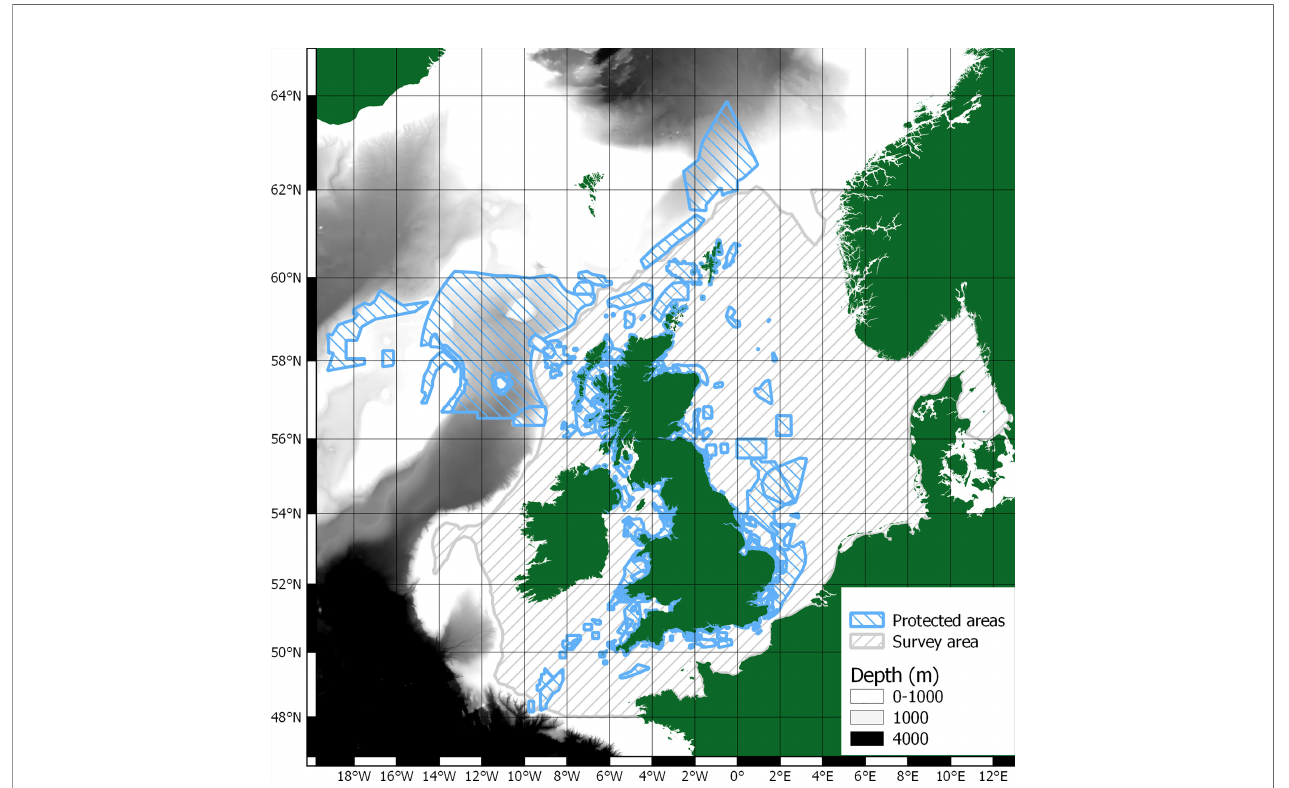
FIGURE 2 | Survey area, protected areas, and >1000m depth